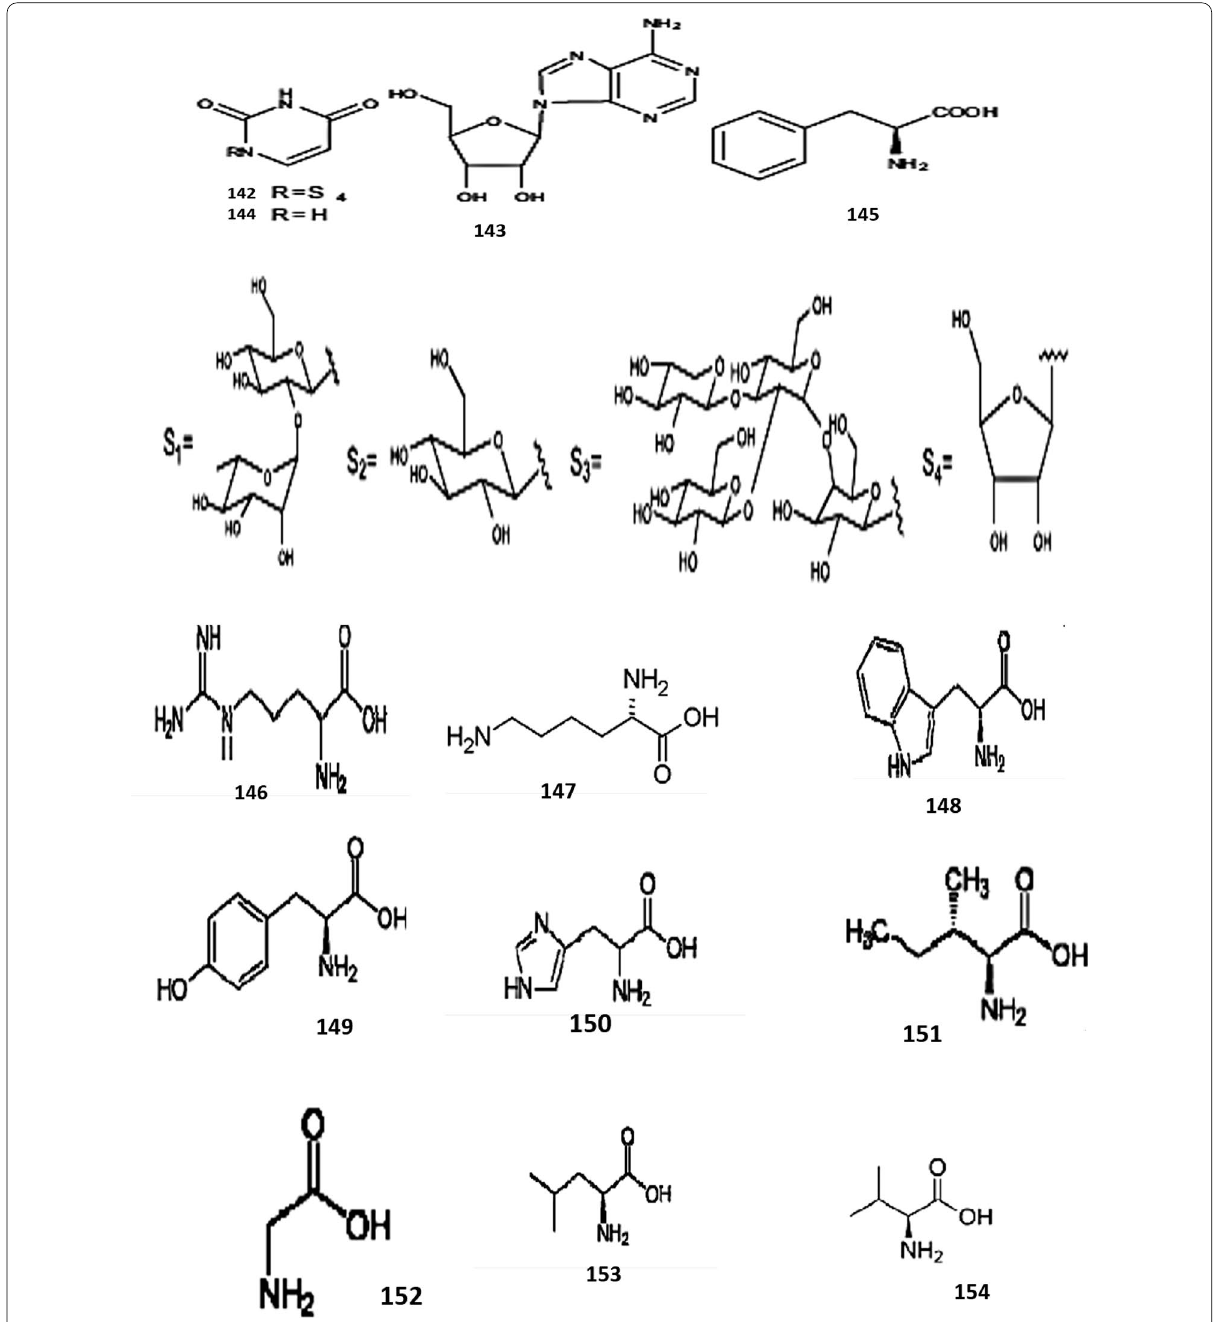
From Fritillaria verticillata bulbs, β-sitosterol-3-O- glucopyranoside a glucosylsterol has been isolated as main principal component (Kim et al. 2003). From Fri- tillaria pallidiflora , Schrenk bulbs steroidal saponins named pallidiflosides A (119), pallidiflosides C (121)